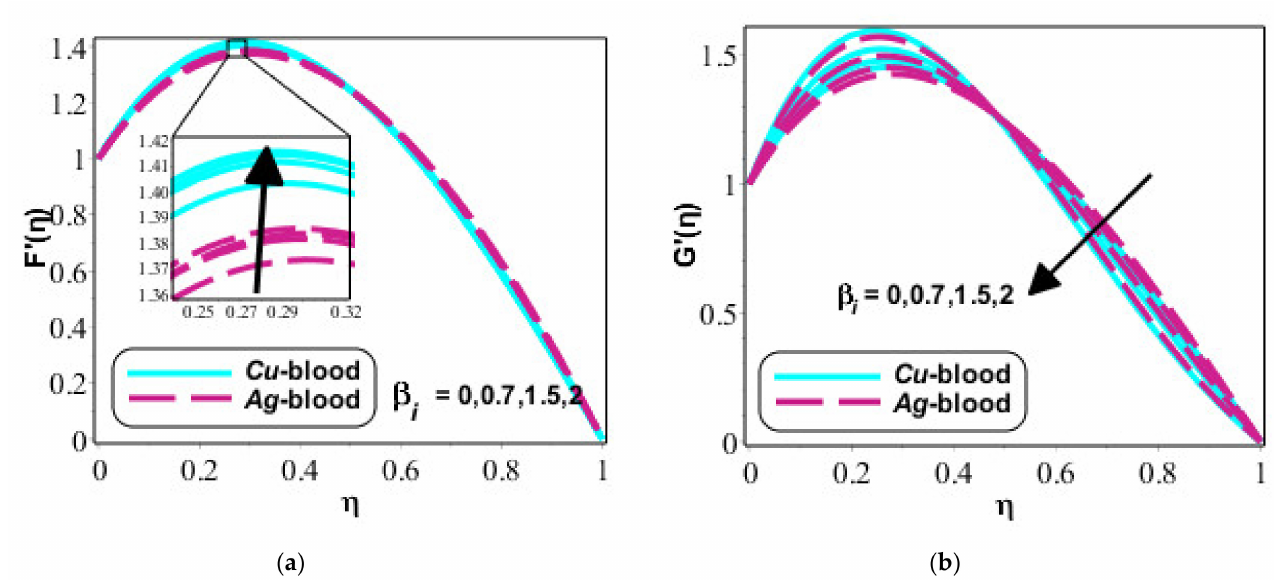
Figure 3. Behaviour of ( a ) F (cid:48) ( η ) and ( b ) G (cid:48) ( η ) as varying β i when φ = 0.1, Re = 5, β e = 0.5, λ = 2, M = 5.